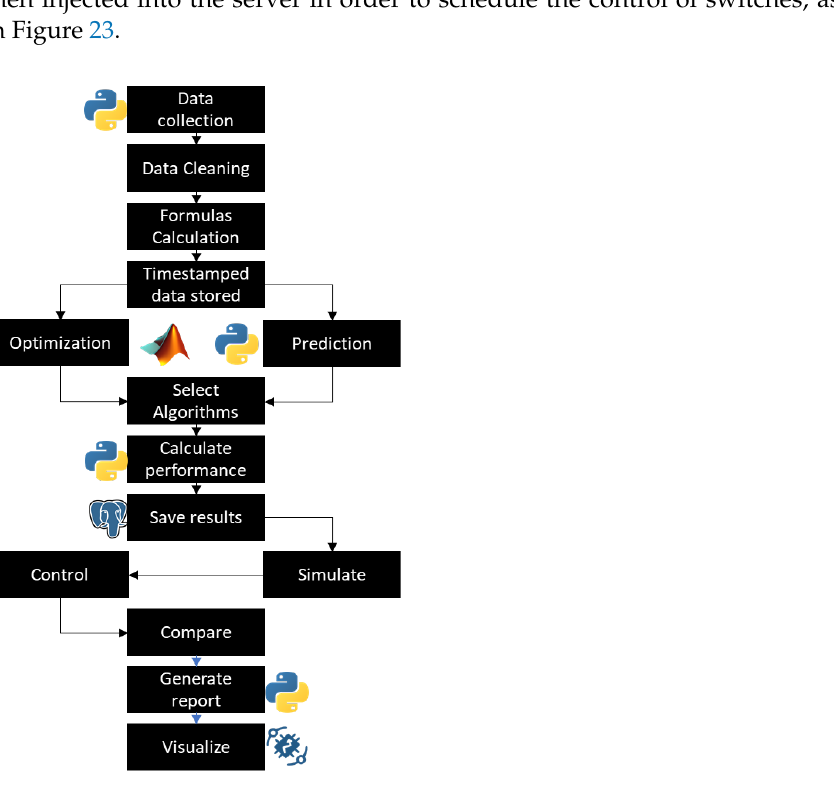
Figure 23. Flowsheet of different steps to co-simulate prediction and optimization.